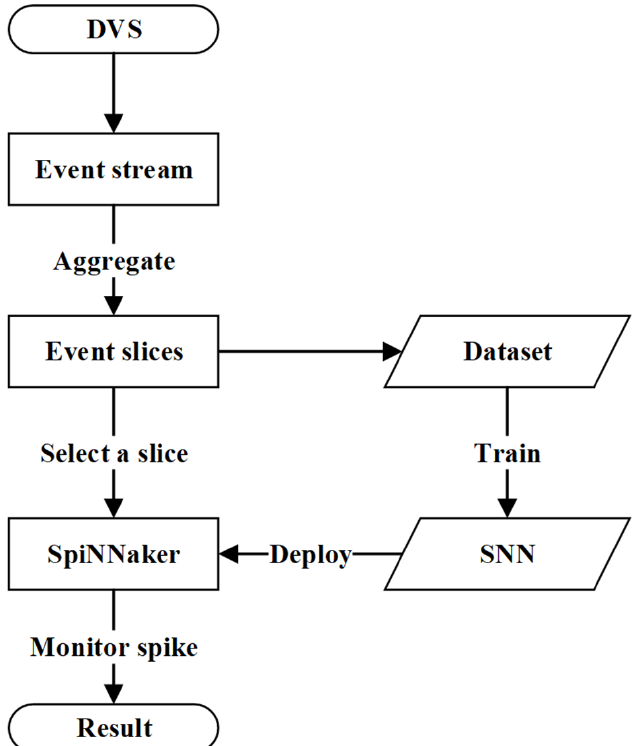
Figure 4. Flow chart of the proposed neuromorphic high-speed object recognition method based on DVS and SpiNNaker. During the training and deployment process, the output of DVS converts to event slices through OR logic aggregation algorithm, and a specific dataset can be created via these slices. Then an SNN is trained through this DVS-based dataset and deployed on SpiNNaker after that. For the inference process, the stream of events acquired in real-time is aggregated into consecutive event slices and fed into SpiNNaker as spikes. After the computation of the SNN, the neurons in output layer will fire corresponding spikes, which refers to the recognition result.